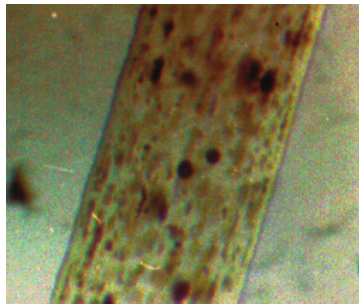
Figure 3 - CHS: hair under light microscopy (x100).